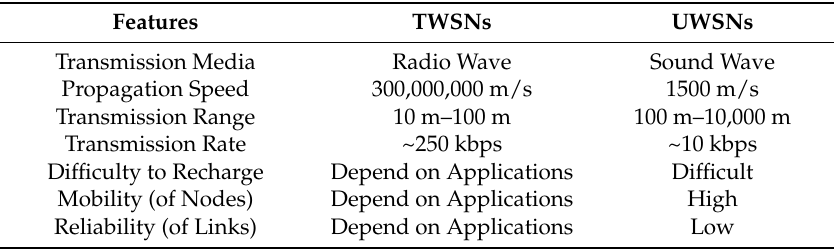
Table 1. The differences between TWSNs and